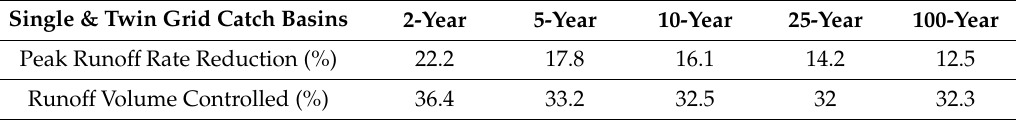
Table 6. Runo ff control performances of single and twin grid catch basin.